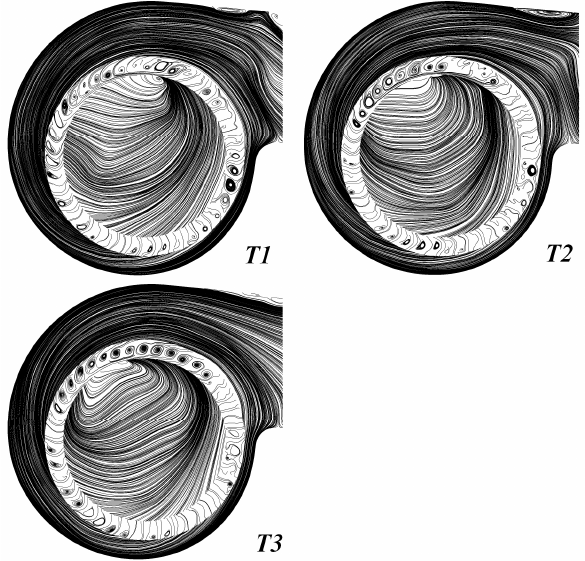
Figure 18. Streamline with time evolution at Z = 0.015 m section (Q/Qn = 0.031).